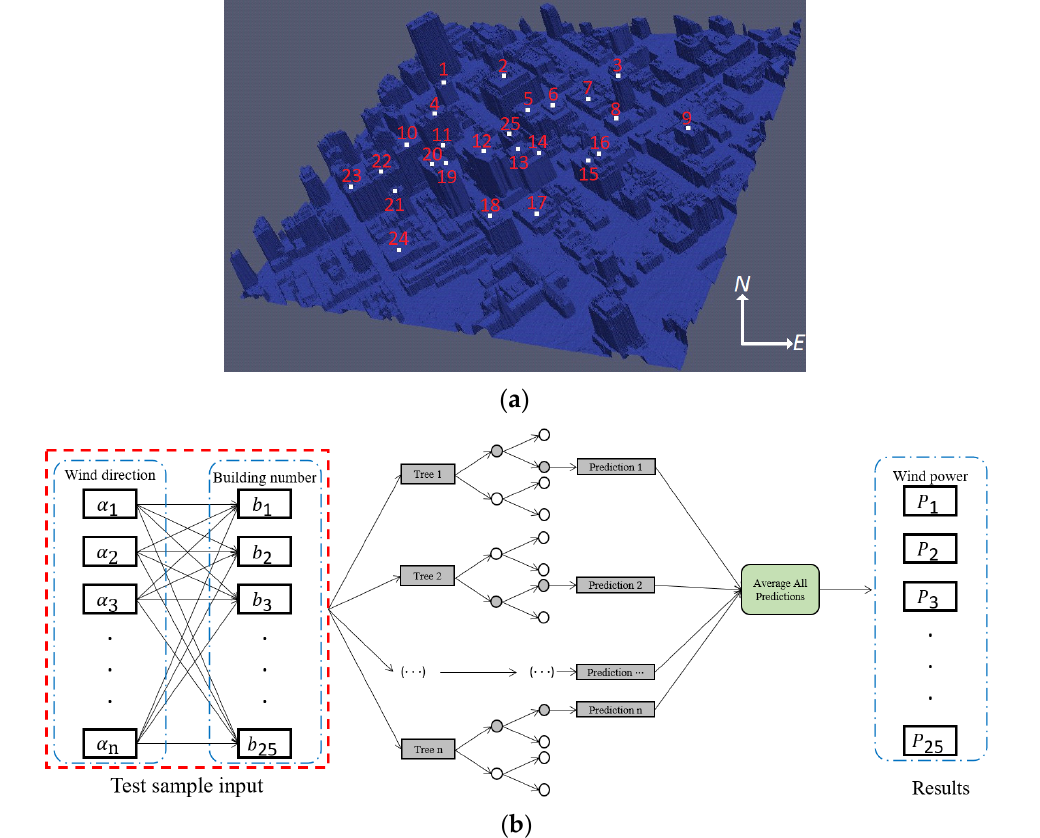
Figure 7. The 25 selected buildings for wind speed calculation. ( a ) Selected buildings for wind power potential calculation with their building numbers. ( b ) Architecture of random forest.